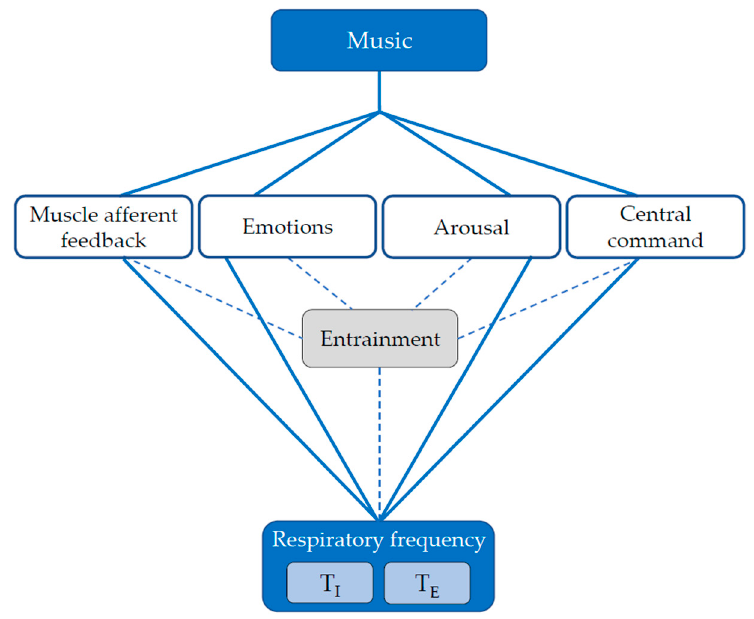
Figure 1. Conceptual framework describing the mechanisms underlying the effect of music on respiratory frequency, inspiratory time, and expiratory time during exercise. Note that the four listed inputs may regulate f R and its subcomponents (T I and T E ) either via entrainment (dashed lines) or not (solid lines).